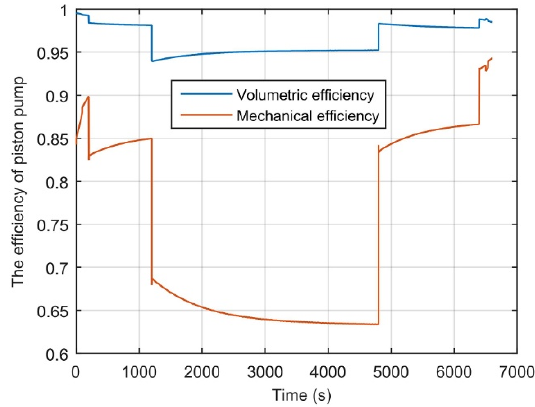
Figure 9. The volumetric and mechanical efficiency of piston pump.